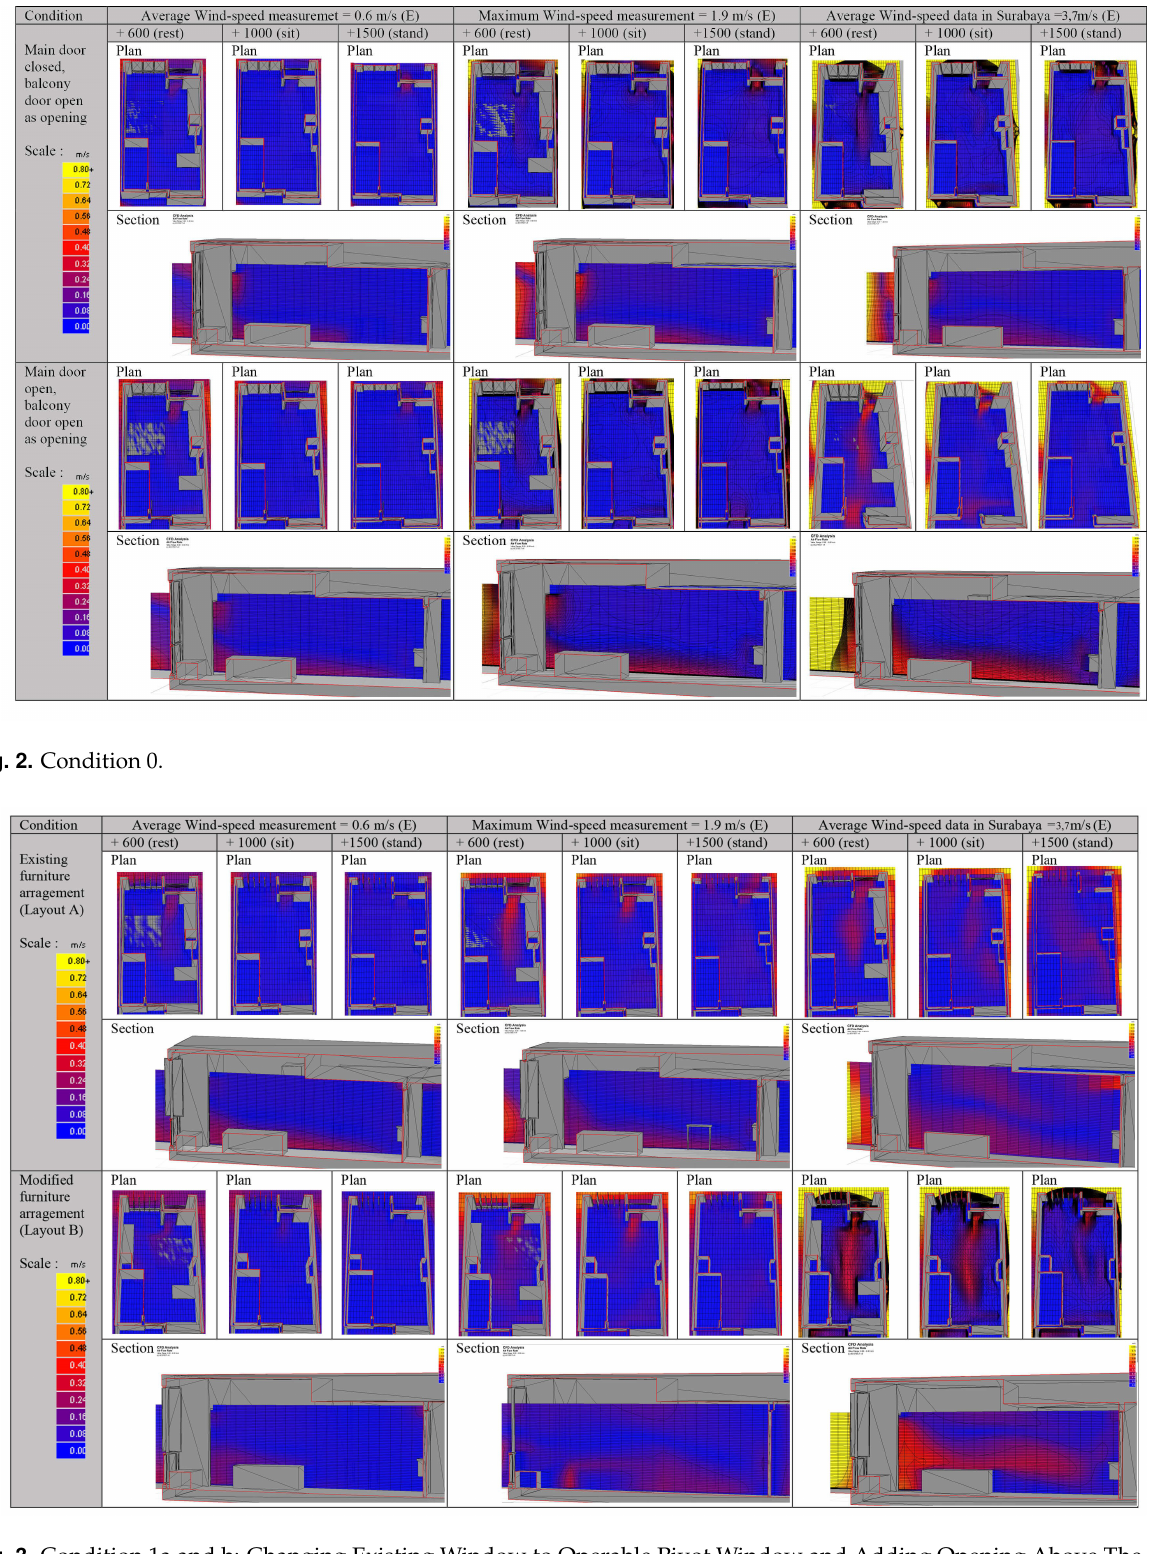
Fig. 3. Condition 1a and b: Changing Existing Window to Operable Pivot Window and Adding Opening Above The